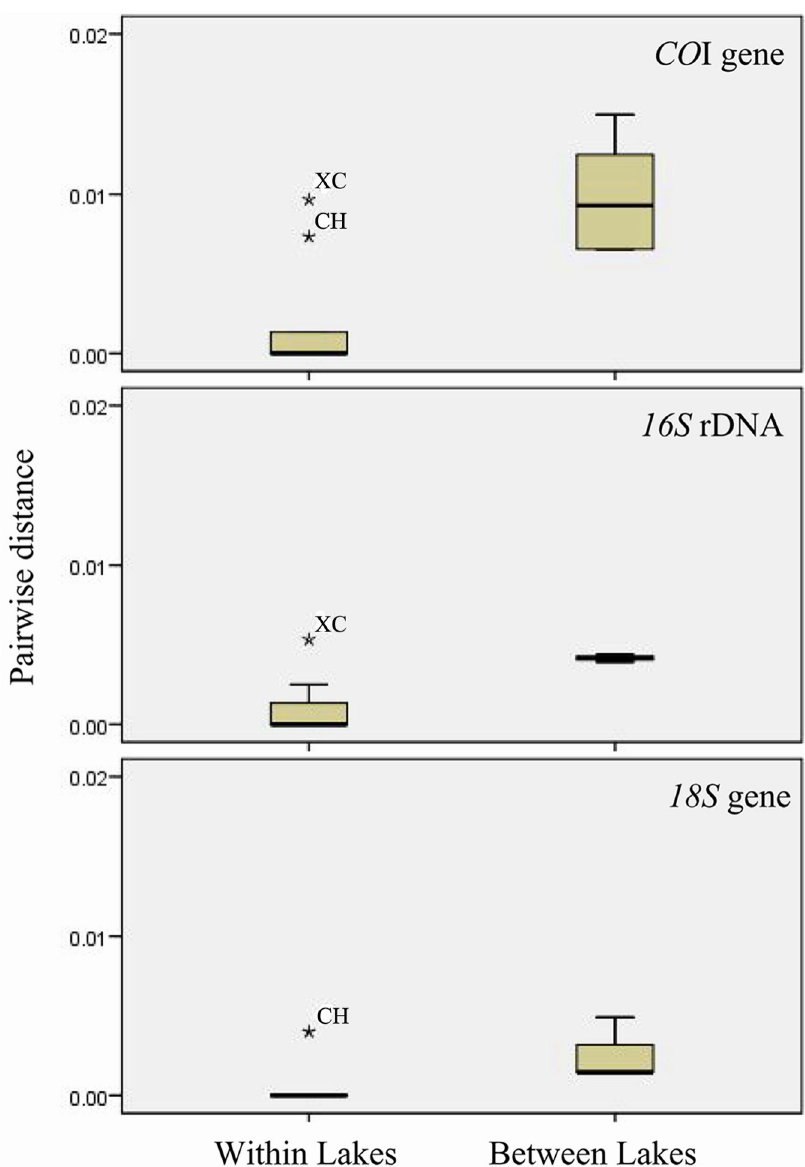
Fig 5. Box diagram of D . pulex genetic diversity within-lakes and between-lakes (XC: Lake Nanyi; CH: Lake Chaohu).